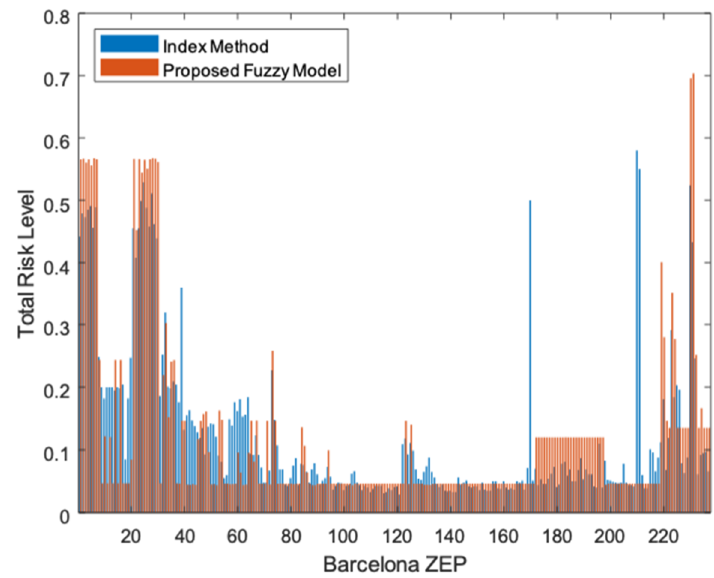
Figure 7. Total Risk values for the 248 Barcelona small statistical areas (ZEP).